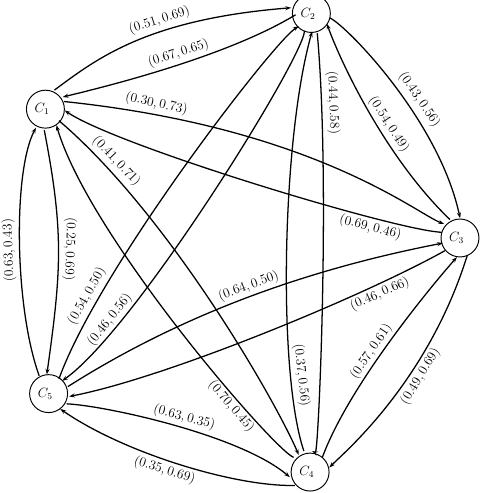
Figure 18. Directed network of the fused PFPR.